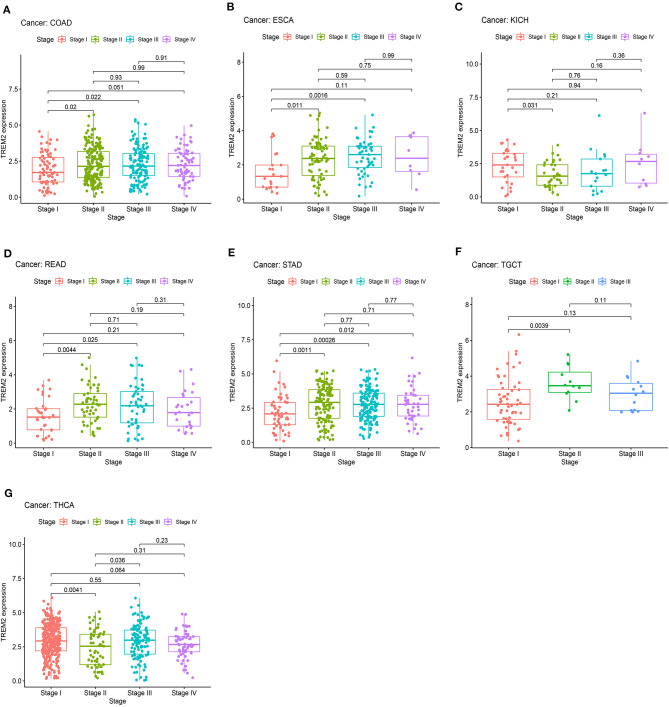
Association between TREM2 expression and tumor stage in (A) colon adenocarcinoma (COAD), (B) esophageal carcinoma (ESCA), (C) kidney chromophobe (KICH), (D) rectum adenocarcinoma (READ), (E) stomach adenocarcinoma (STAD), (F) testicular germ cell tumors (TGCT), and (G) thyroid carcinoma (THCA).